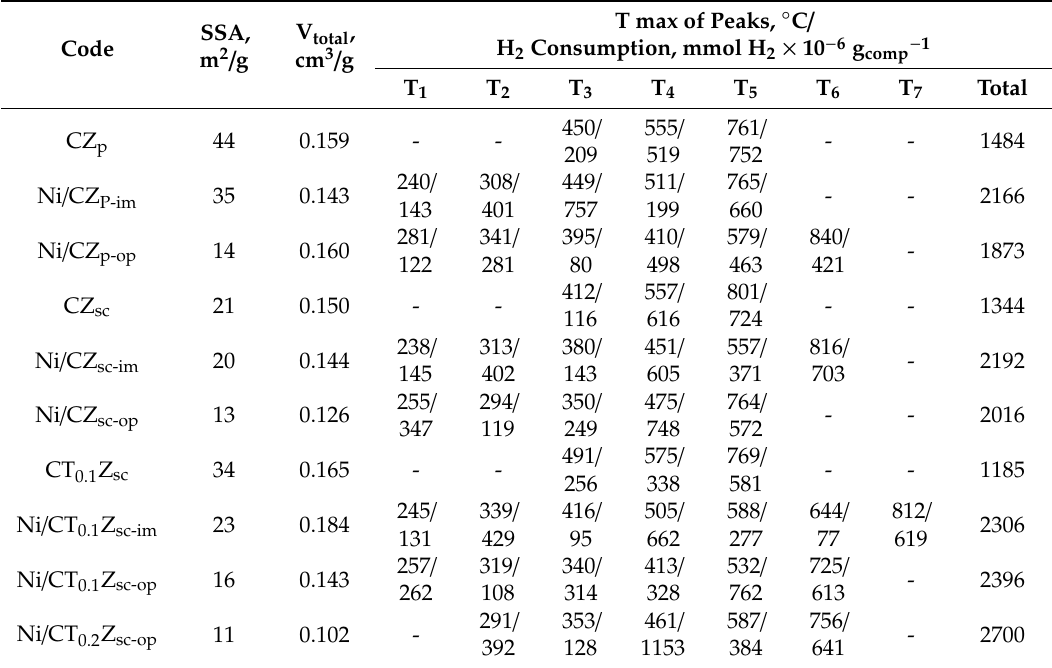
Table 2. Physicochemical properties of supports and 5%Ni / Ce-Zr(Ti)O 2 catalysts.